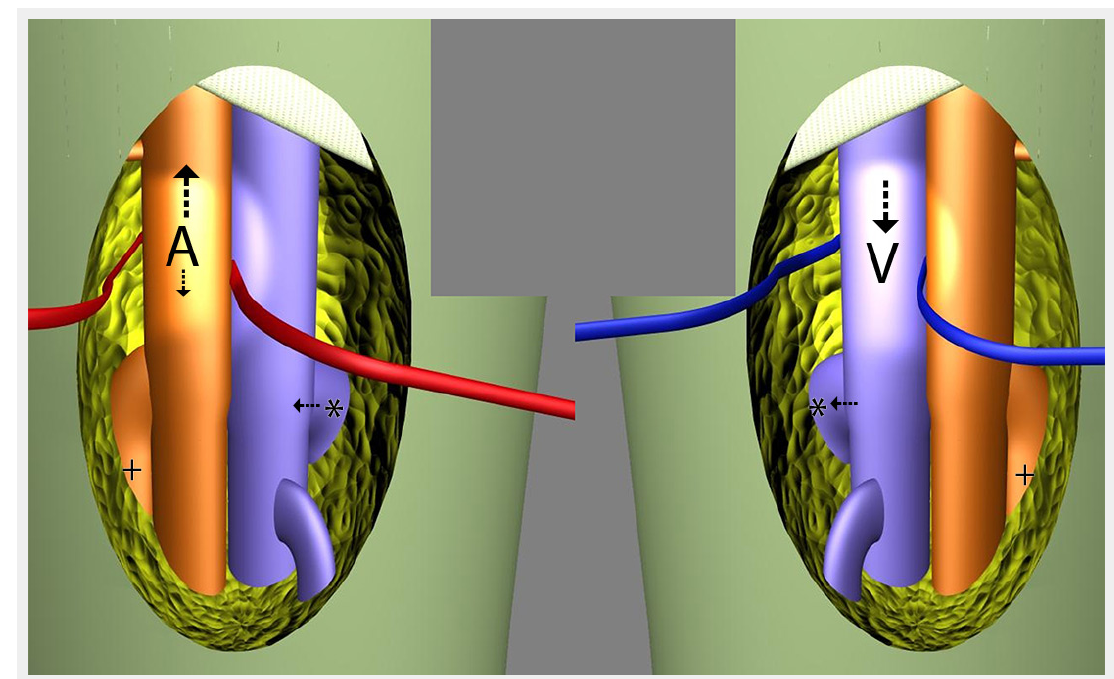
Figure 2 Schematic view of ipsilateral dual arterial cannulation and contralateral venous cannulation just caudal to the inguinal ligaments: systemic arterial cannulation (A) cephalad to the deep femoral artery (+), ipsilateral second arterial cannulation (D) for distal perfusion and contralateral venous cannulation (V) cephalad to the deep femoral vein (*). Collateral venous drainage is possible via the bilateral deep femoral veins (*) and the pelvic collaterals. The same holds true for the collateral flow via the bilateral deep femoral arteries (+). Although percutaneous cannulation on a routine basis is preferred, an open technique is displayed here for better identification of the femoral vessels and their branches.